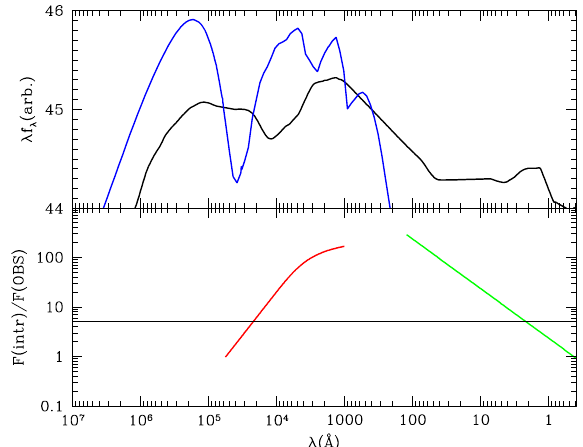
Figure 2: Top: simulated SEDs of a SB (blue) and an AGN (black) contributing to 80% and 20% respectively of the L bol . Bottom: extinction of the AGN emission by gas (green) and dust (red), the horizontal black line indicates an absorption factor of 5. The AGN is un- detectable in the range 3 µ m-2 ˚A due to dust and gas extinction, and at λ ≥ 10 µ m for the SB dilution. Only the hardest X-rays and 3-10 µ m observations reveal the